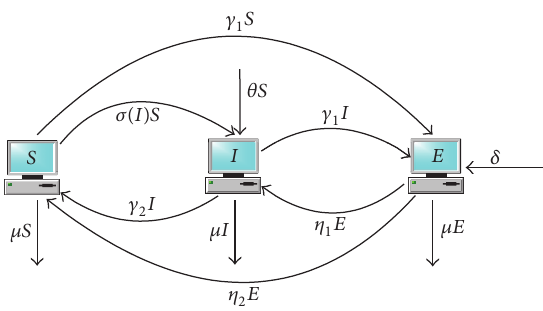
Figure 1: The transfer diagram of the proposed